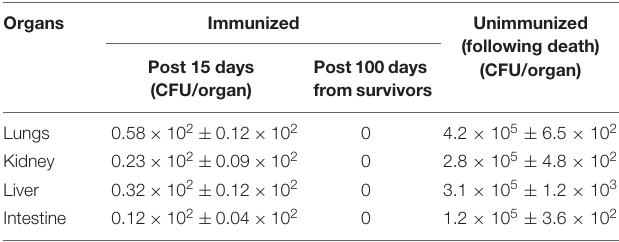
TABLE 5 | Viable bacterial counts for tissues from different experimental groups of challenged mice. Organs Immunized Unimmunized (following death) (CFU/organ)Post 15 days Post100days (CFU/organ)